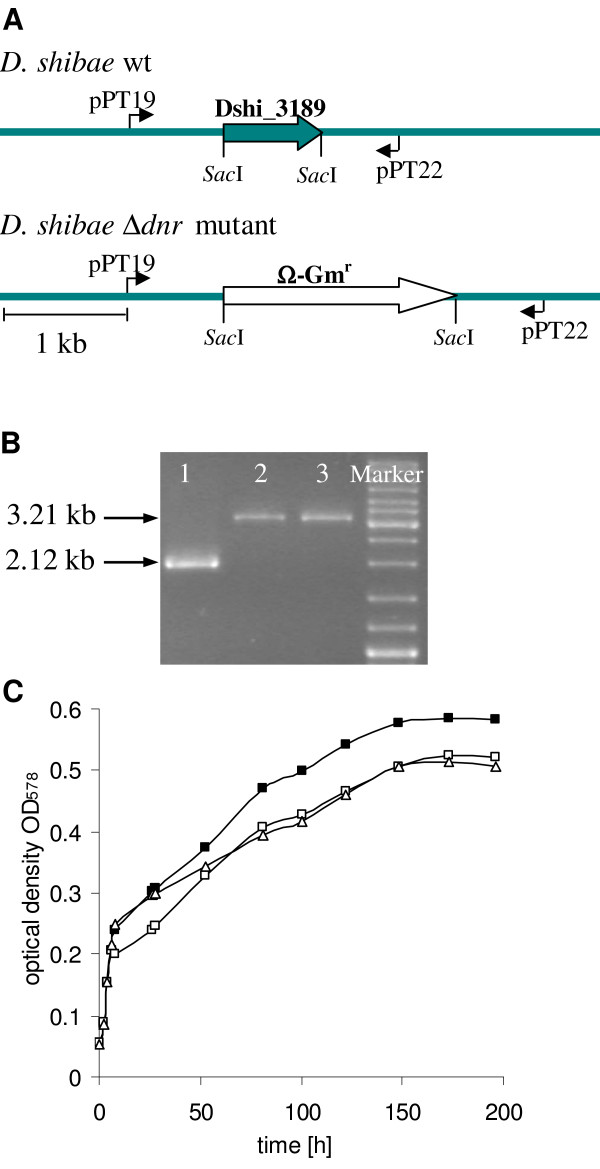
Gene knockout strategy in D. shibae DFL12T. (A) Schematic presentation of the dnr locus of D. shibae DLF12T wildtype and the corresponding Δdnr-mutant. The deletion of Dshi_3189 (dnr) after homologous recombination into the D. shibae DFL12T genome was confirmed by (B) PCR of D. shibae DFL12T (line 1) and the Δdnr knockout mutants (line 2 and 3), using the primers oPT19 and oPT22 and by (C) growth of D. shibae DFL12T and two Δdnr knockout mutants in MB supplemented with 25 mM nitrate under anaerobic conditions at 30°C and 100 rpm. Shown are the growth curves of D. shibae DFL12T (-■-), D. shibae DFL12Δdnr1 (-□-) and D. shibae DFL12Δdnr2 (-Δ-).